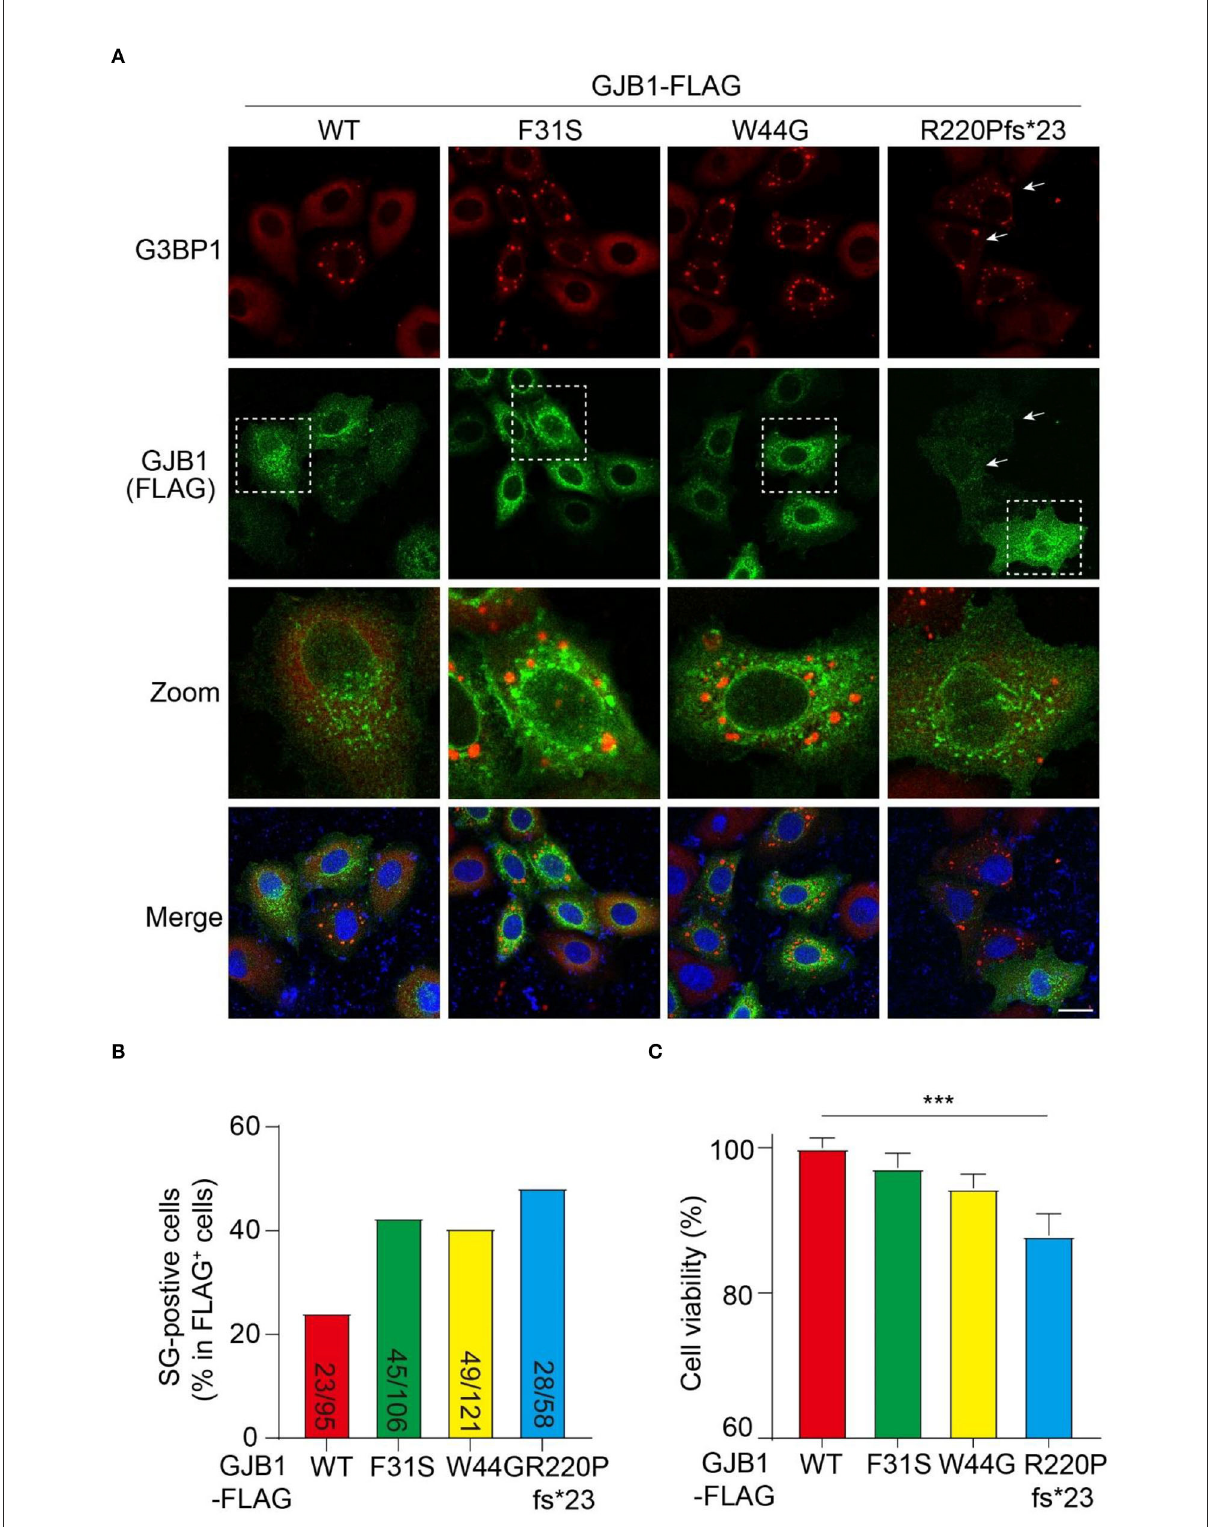
FIGURE7 GJB1 mutations induce more stress granule formation and impaired cell activity. (A) Immunofluorescence staining of FLAG-tagged GJB1 variants within transfected HeLa cells. Red, anti-G3BP1 staining; Green, anti-FLAG staining; Blue, DAPI-labeled nuclei. Dashed boxes were zoomed in the panel below. Arrows indicate cells with obvious G3BP1 puncta but a small amount of GJB1. (B) Number of SG-positive cells and FLAG-positive cells were blindly counted from individual immunofluorescent images and were shown as indicated. (C) Cell activity of GJB1-overexpressing HeLa cells was determined by CCK-8 assay. *** P < 0.0001. Scale bar, 20 µ